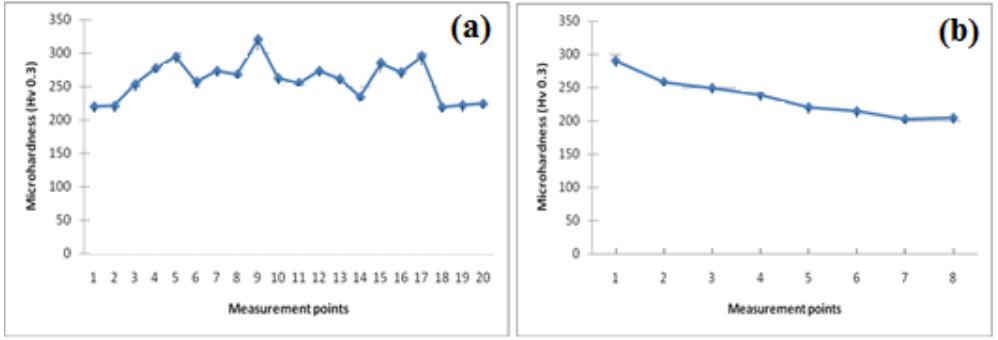
Figure 7. Microhardness test results of sample S2 ( a ) horizontal and ( b ) vertical.